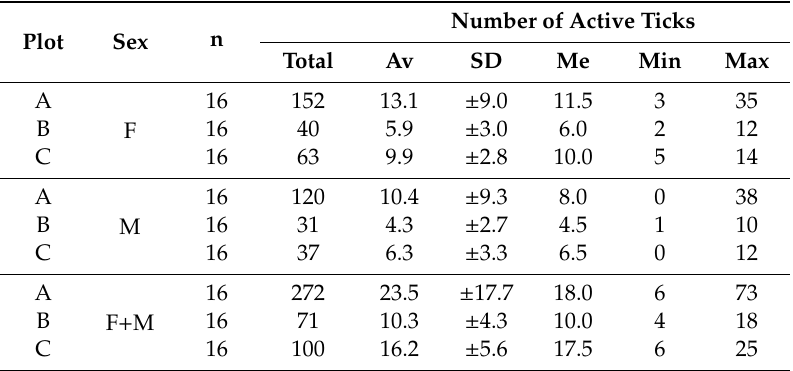
Table 1. Number of Dermacentor reticulatus adults exhibiting activity in the examined localities in eastern Poland (2019).